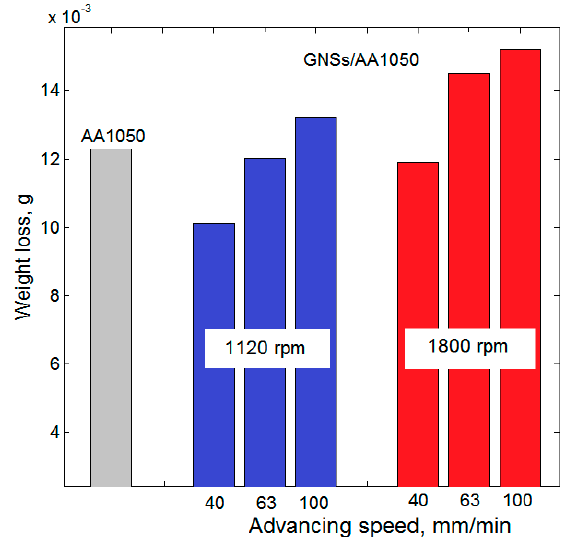
Figure 8. Weight loss of the AA1050-H24 alloy and the composite GNS/AA1050 as function of FSP parameters.